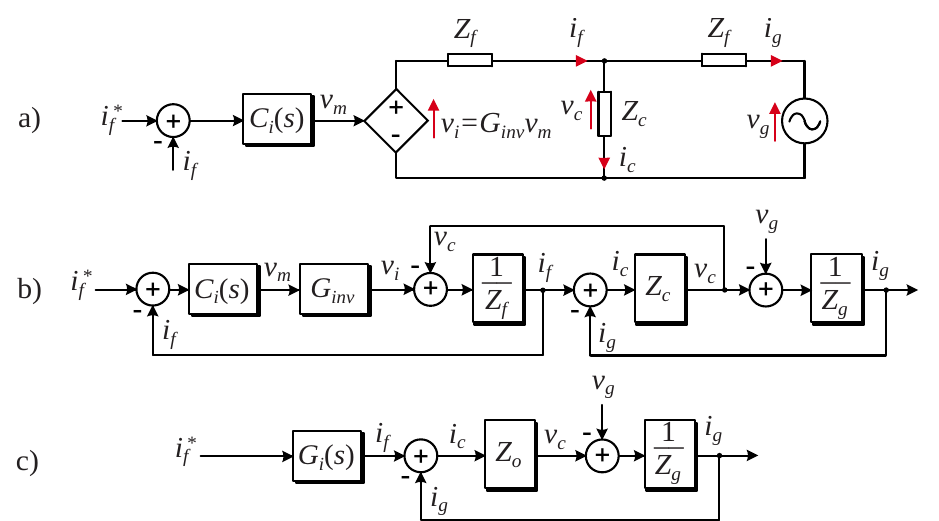
Figure 7. Output impedance model: ( a ) average circuit model, ( b ) simplified control model, ( c ) derived Norton